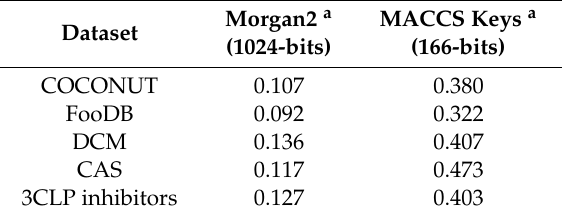
Table 4. Summary of the fingerprint-based structural diversity of the entire compounds. Dataset